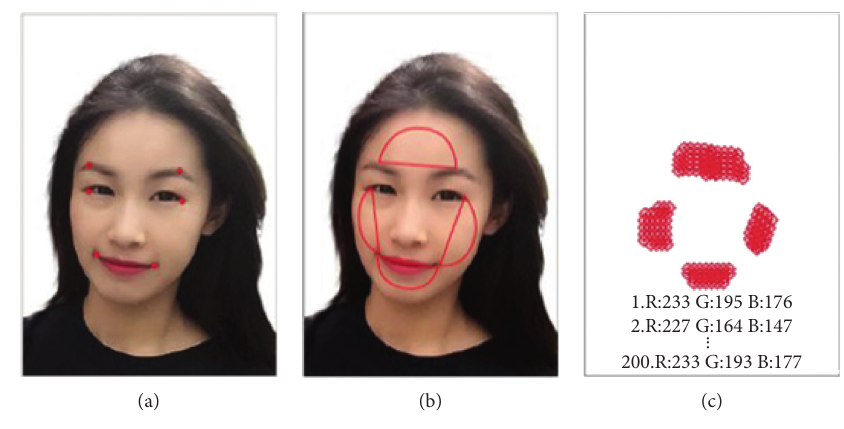
Figure 4: The distribution possibility for input in